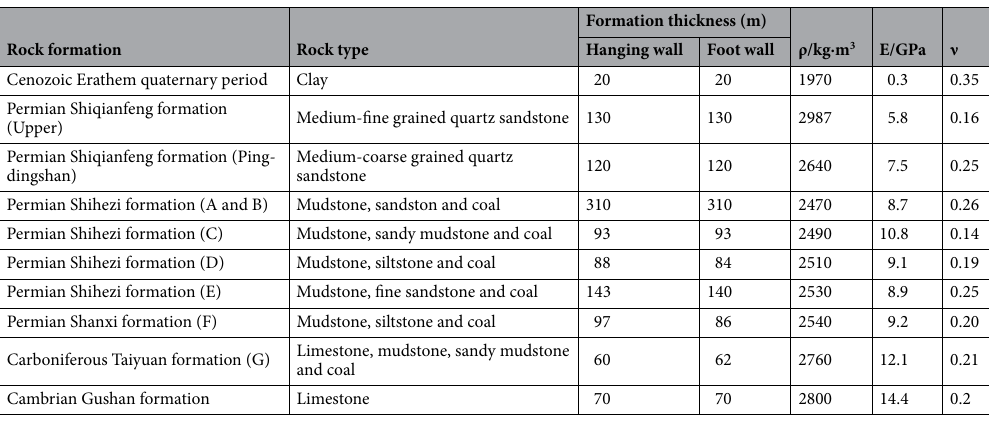
Table 1. Geological formations. F 16-17 coal seam is contained in Permian Shanxi